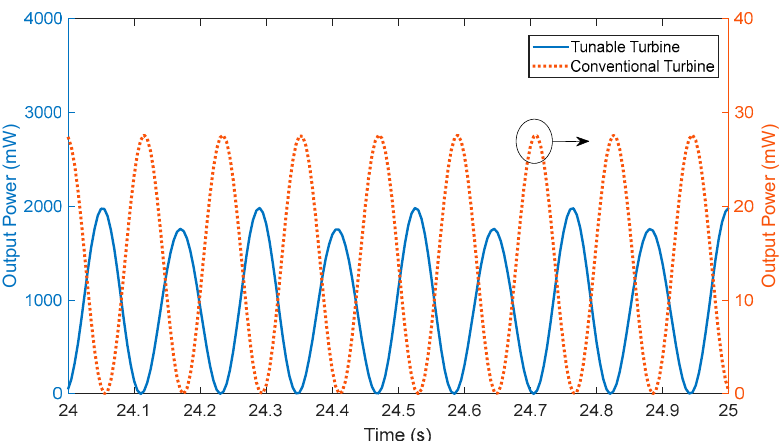
Figure 6. Output power of the tunable and conventional VBWT at U f = 4.22 m/s and k 2 = 2034 N/m.